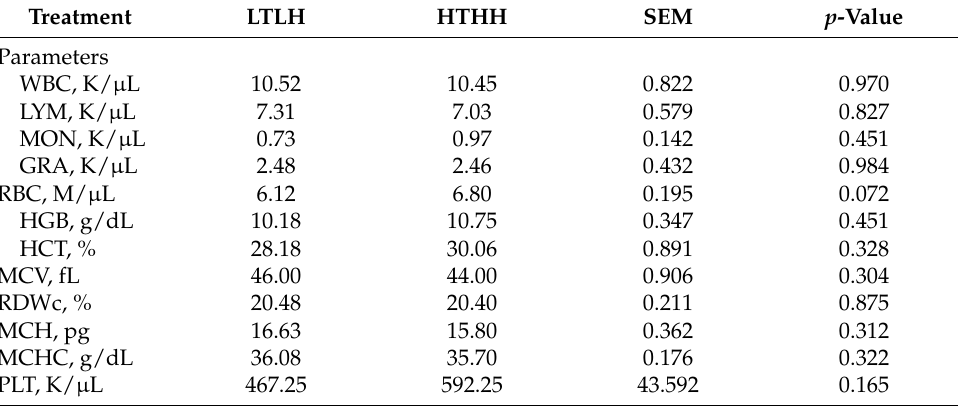
Table 4. Blood hematological profile in dairy cows exposed to two distinct environmental